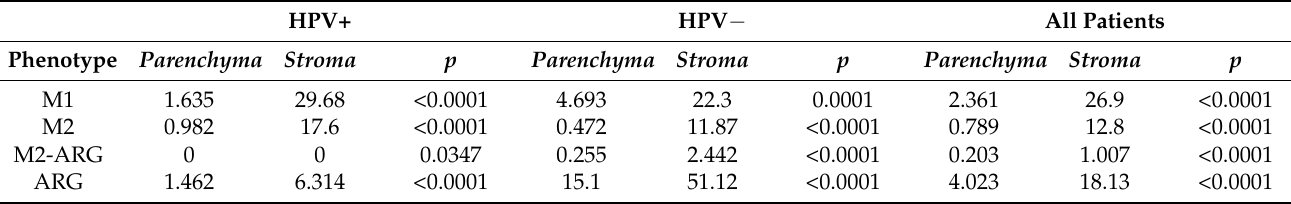
Table 4. TAMs and arginase (ARG) phenotype infiltration in tumor parenchyma and stroma expressed by median values of cells/Mpx.